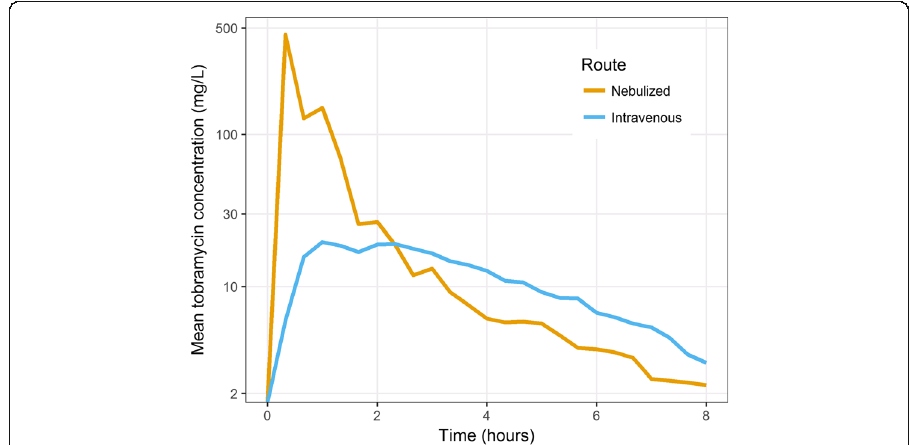
Table 4 Comparative epithelial lining fluid concentrations for nebulised and tobramycin sheep at two time points, 1 and 6 h post-antibiotic administration ELF time points Nebulised tobramycin